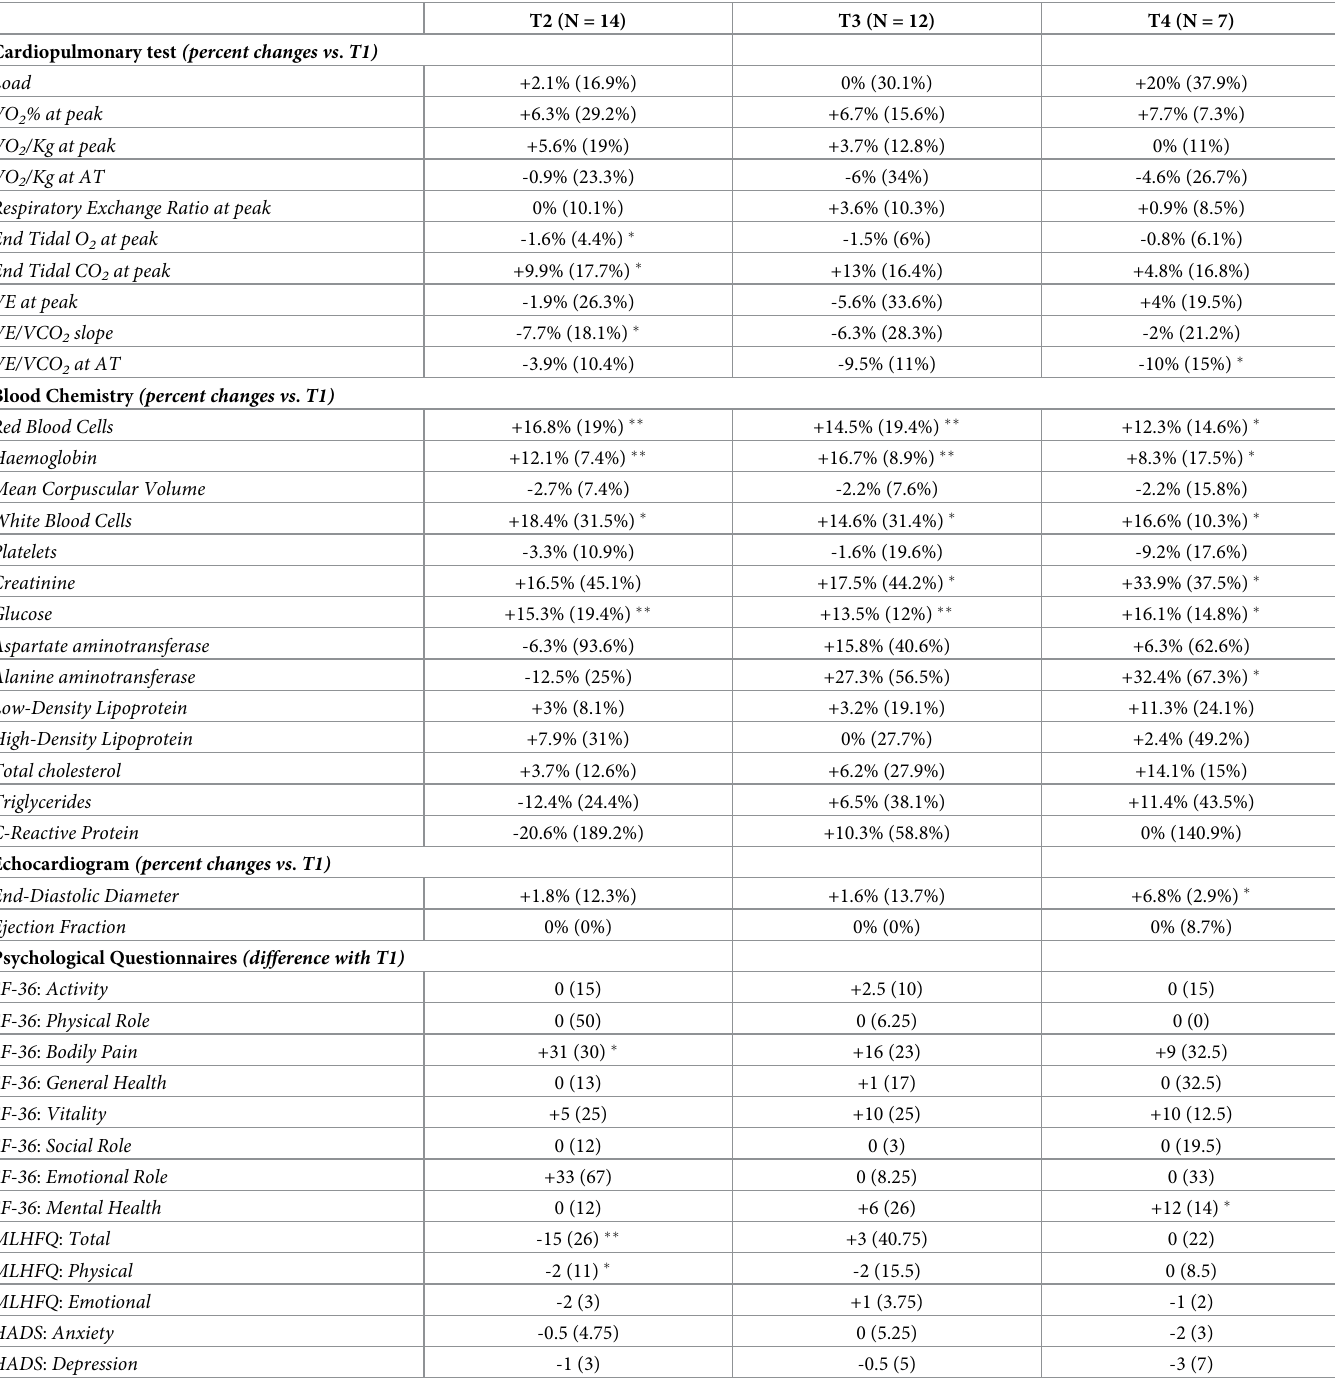
Table 3. LVAD patients at follow-ups: Percent change vs. T1 of blood chemistry and cardiopulmonary measures and difference vs. T1 in the scores of the psycho- logical